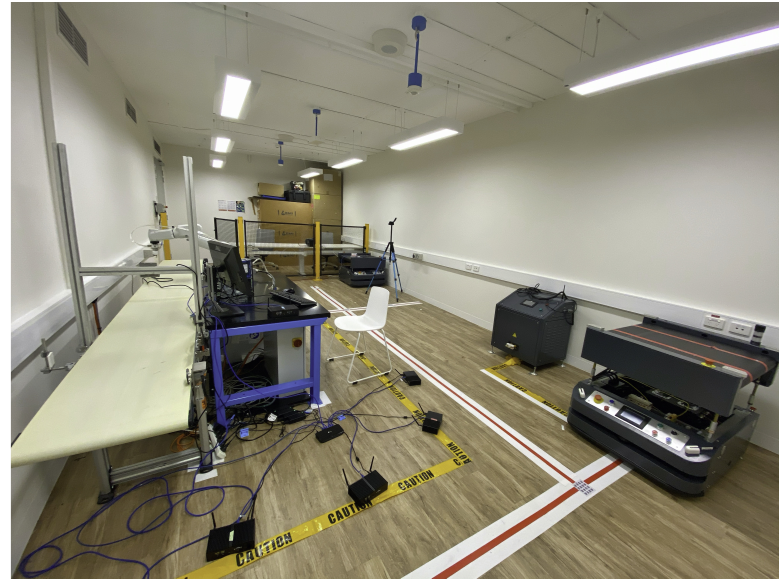
Figure 6. Experiment